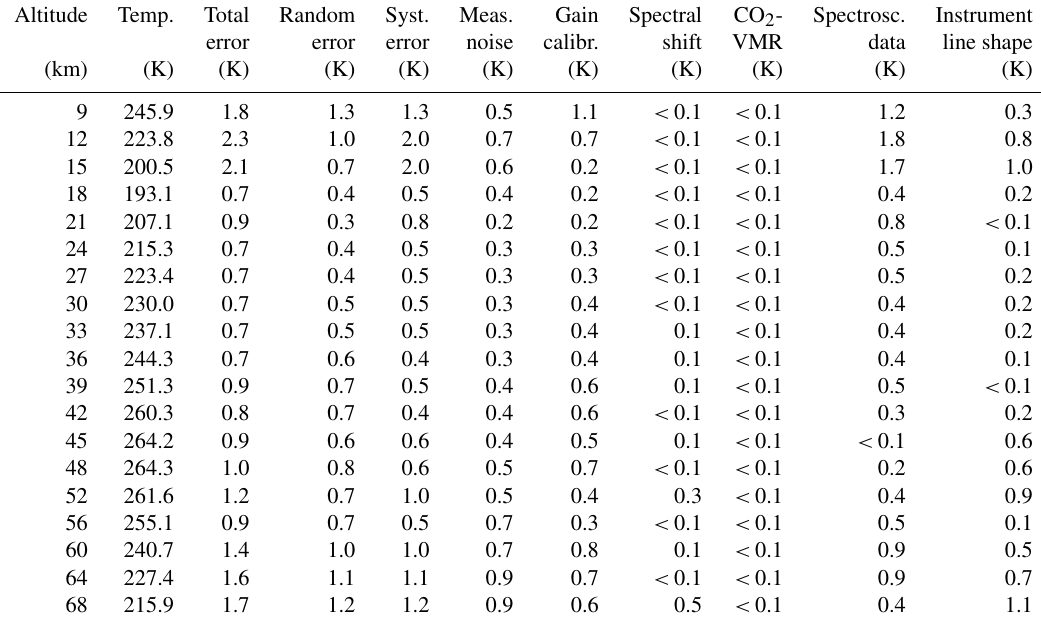
Table A6. FR data temperature error budget for tropical day. All uncertainties are 1 σ . Altitude